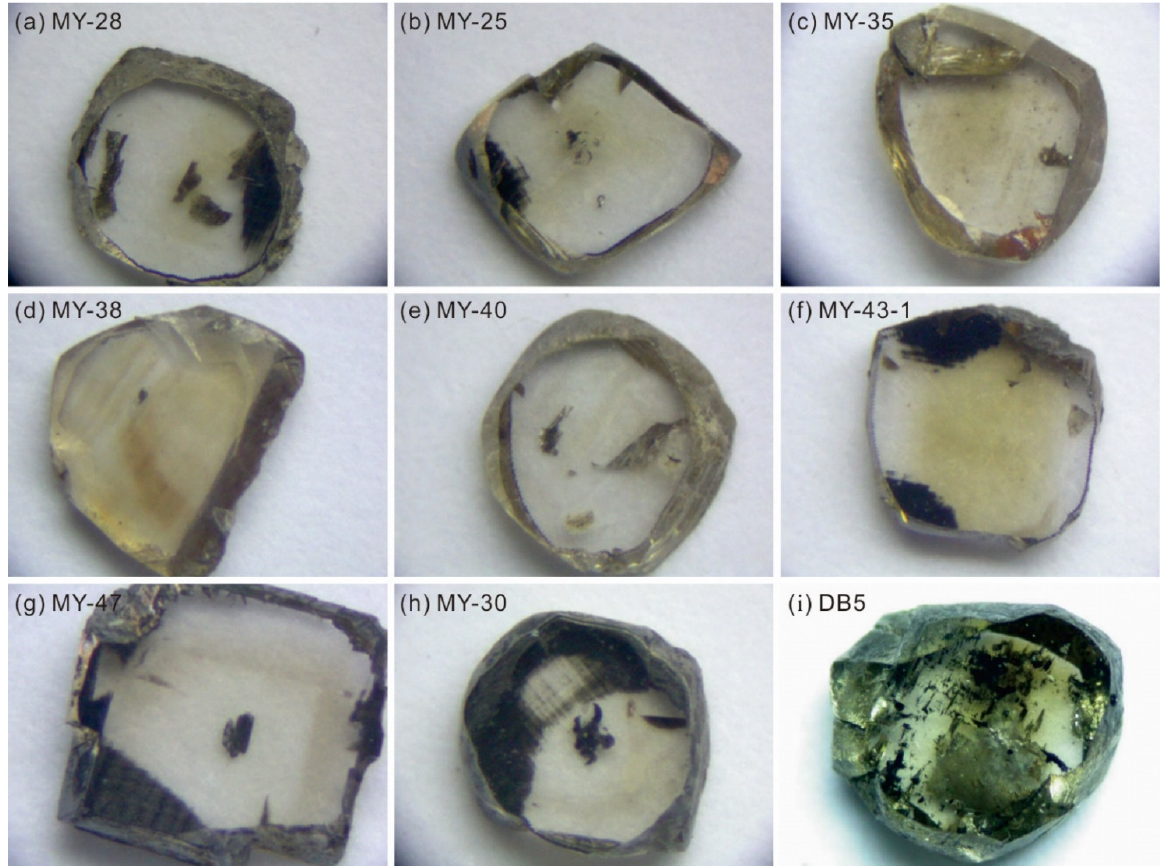
Figure 1. The color features of brown diamond from the Mengyin deposit. ( a ) Unevenly colored, two black micro-inclusions surrounded by light brown color patches in the right sector compared to the colorless sector to the left (maximum diameter abbreviated as MD 3.64 mm); ( b ) Uneven in color, abundant black inclusions surrounded by brown color patches in the core and lighter color sector along the periphery (MD 3.29 mm); ( c ) Brown bands are straight and thin in the core, and run through the whole sample from the upper right to the lower left (MD 3.63 mm); ( d ) Brown bands are wide and run through the whole sample from the upper right to the lower left (MD 3.66 mm); ( e ) Faint brown bands occur in the core, the brown color patch and small inclusions such as microfractures and the tiny particles so abundant in three brown zones (MD 2.77 mm); ( f ) Evenly brown patch rimmed by colorless sides to the left and right (MD 3.09 mm); ( g ) Black inclusions surrounded by colorless sector in the core, square-shaped brown patches in the mantle rimmed by colorless sector (MD 2.60 mm); ( h ) MY-30 color is not uniform, with Black inclusions in the core rimmed changing colors from colorless to light brown (MD 2.80 mm); ( i ) Abundant black inclusions and fractures associated with the brown zones (MD 2.74 mm).